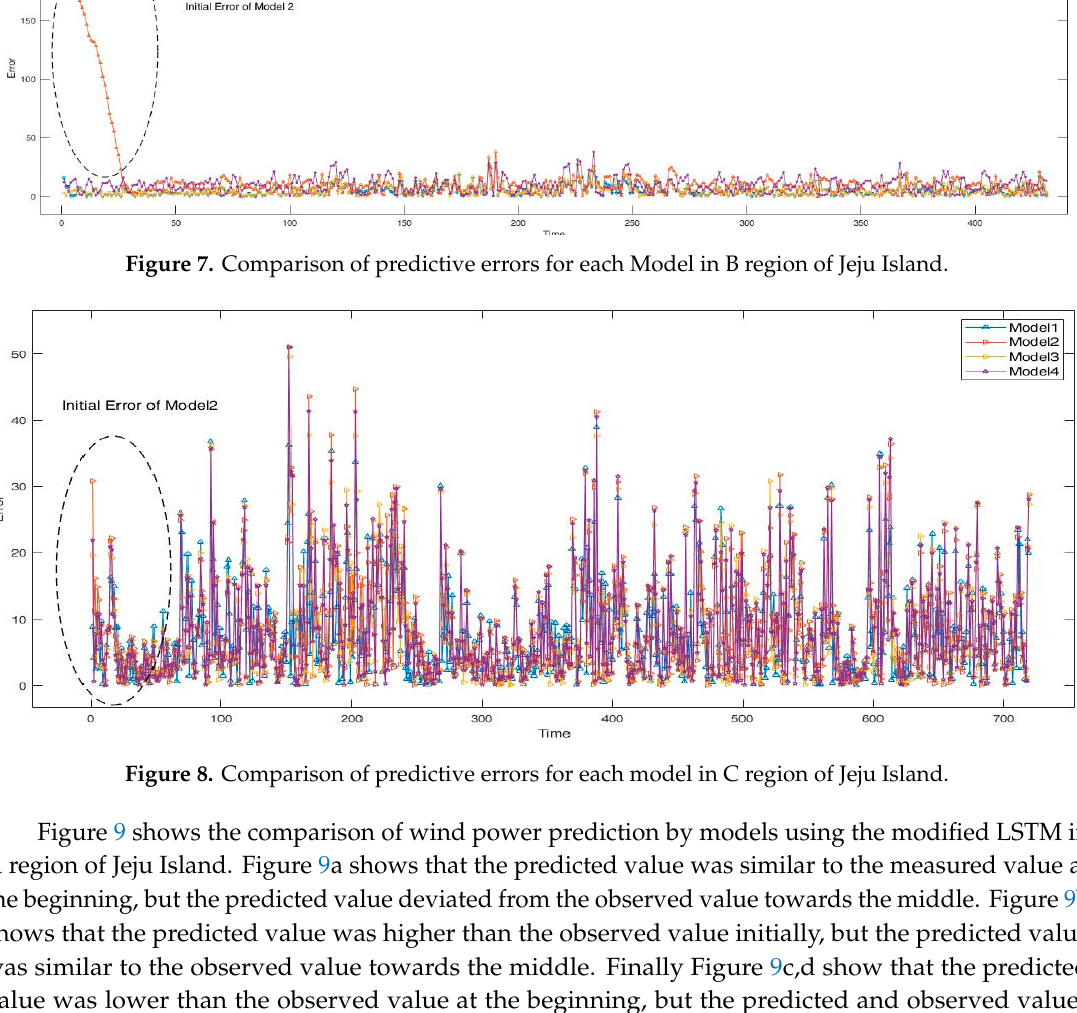
Figure 6. Comparison of predictive errors for each model in A region of Jeju Island.